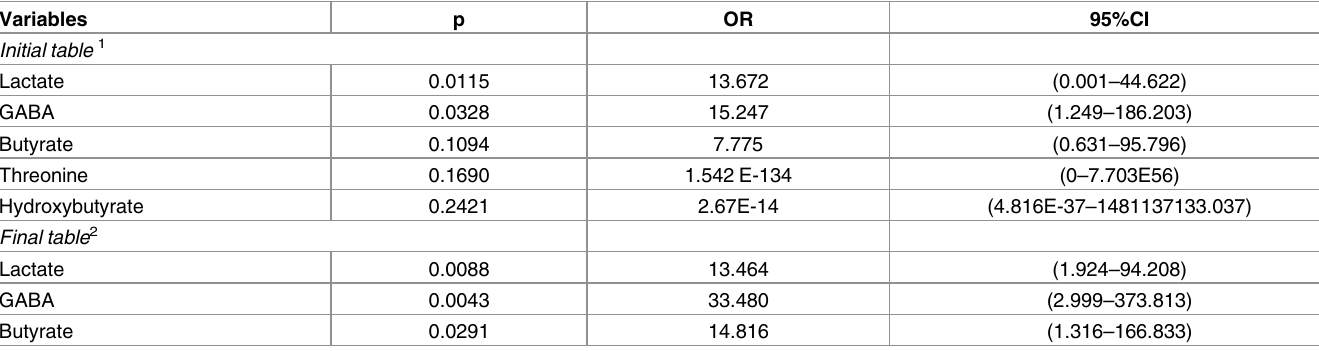
Table 3. Multivariate logistic regression